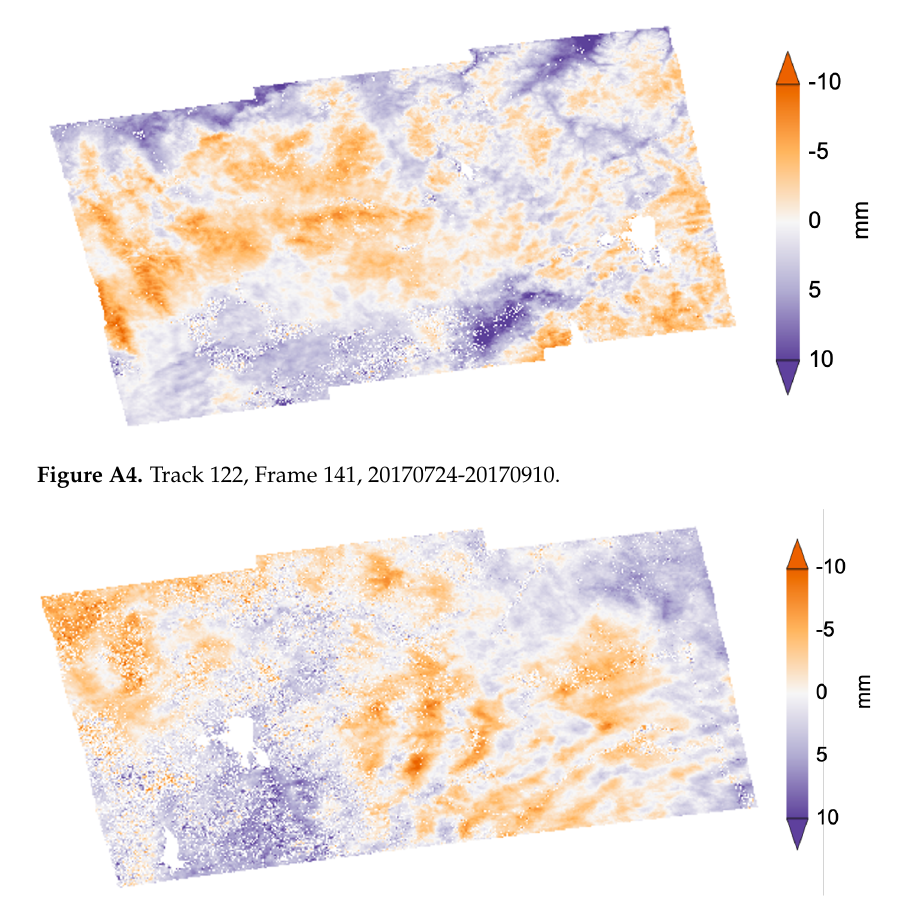
Figure A5. Track 49, Frame 142,